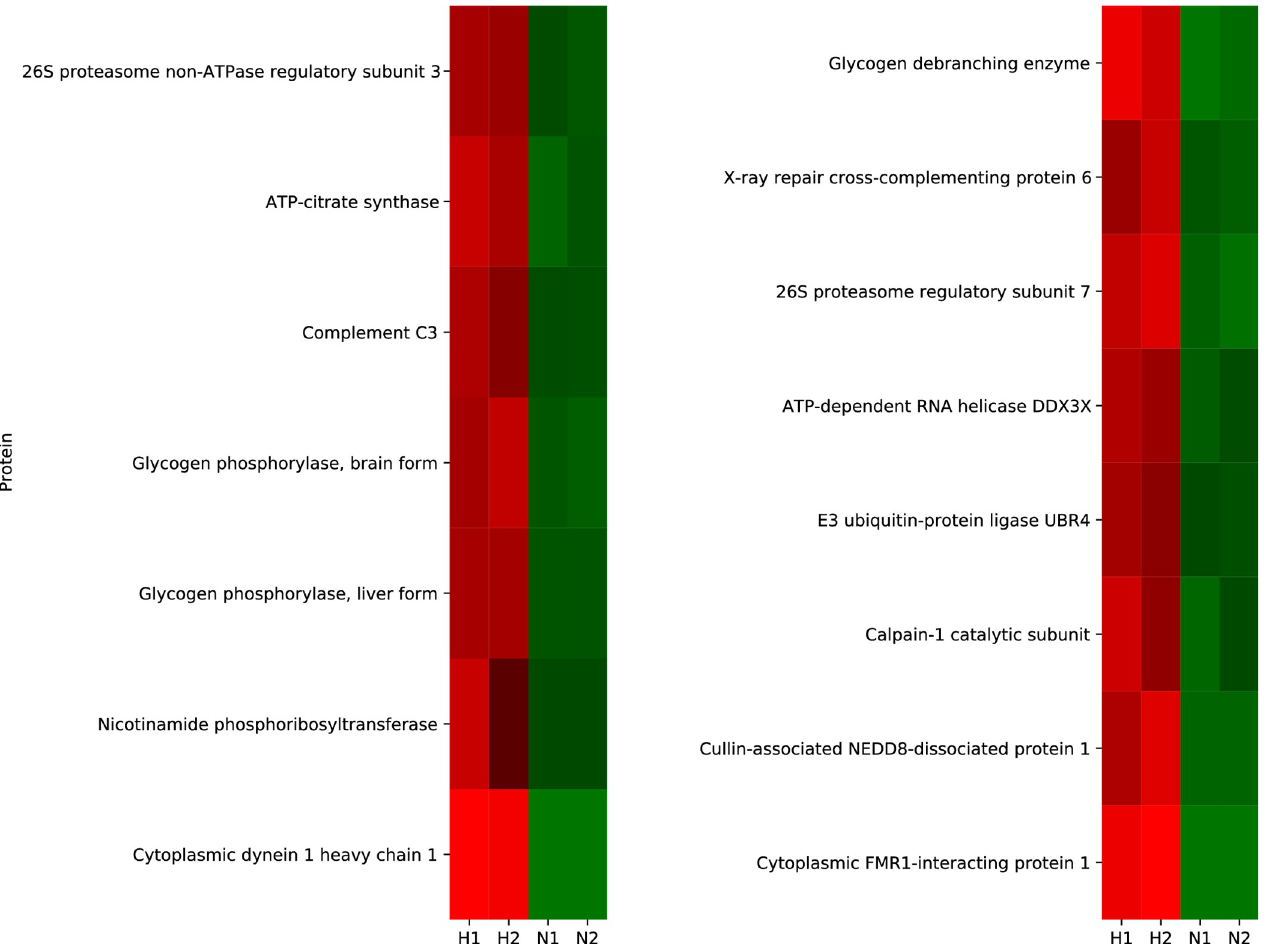
Fig 4. Heatmap showing the changes in inflammation-related protein expression after ischemic stimulation. The protein contents of exosomes were extracted and quantified using high-performance liquid chromatography-mass spectrometry. Inflammation-related proteins that showed > 2-fold increase/ decrease and p < 0.01 (based on Student’s t -test) between the normoxia and hypoxia groups. The changes in the expression of all proteins identified in the experiment are provided in S2 Fig. Values increase progressively from blue to red on the color scale. N1 and N2, normoxia samples; H1 and H2, hypoxia